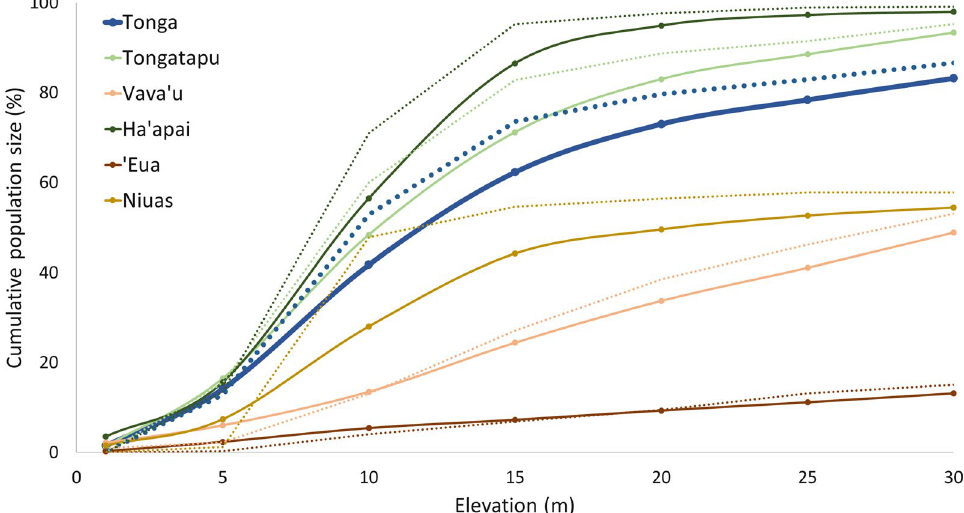
Fig. 4 Cumulative distribution of population and buildings for all Tonga and for each of the 5 divisions (group of islands), paired by color as a function of elevation. Full lines: population distribution. Dotted lines: buildings